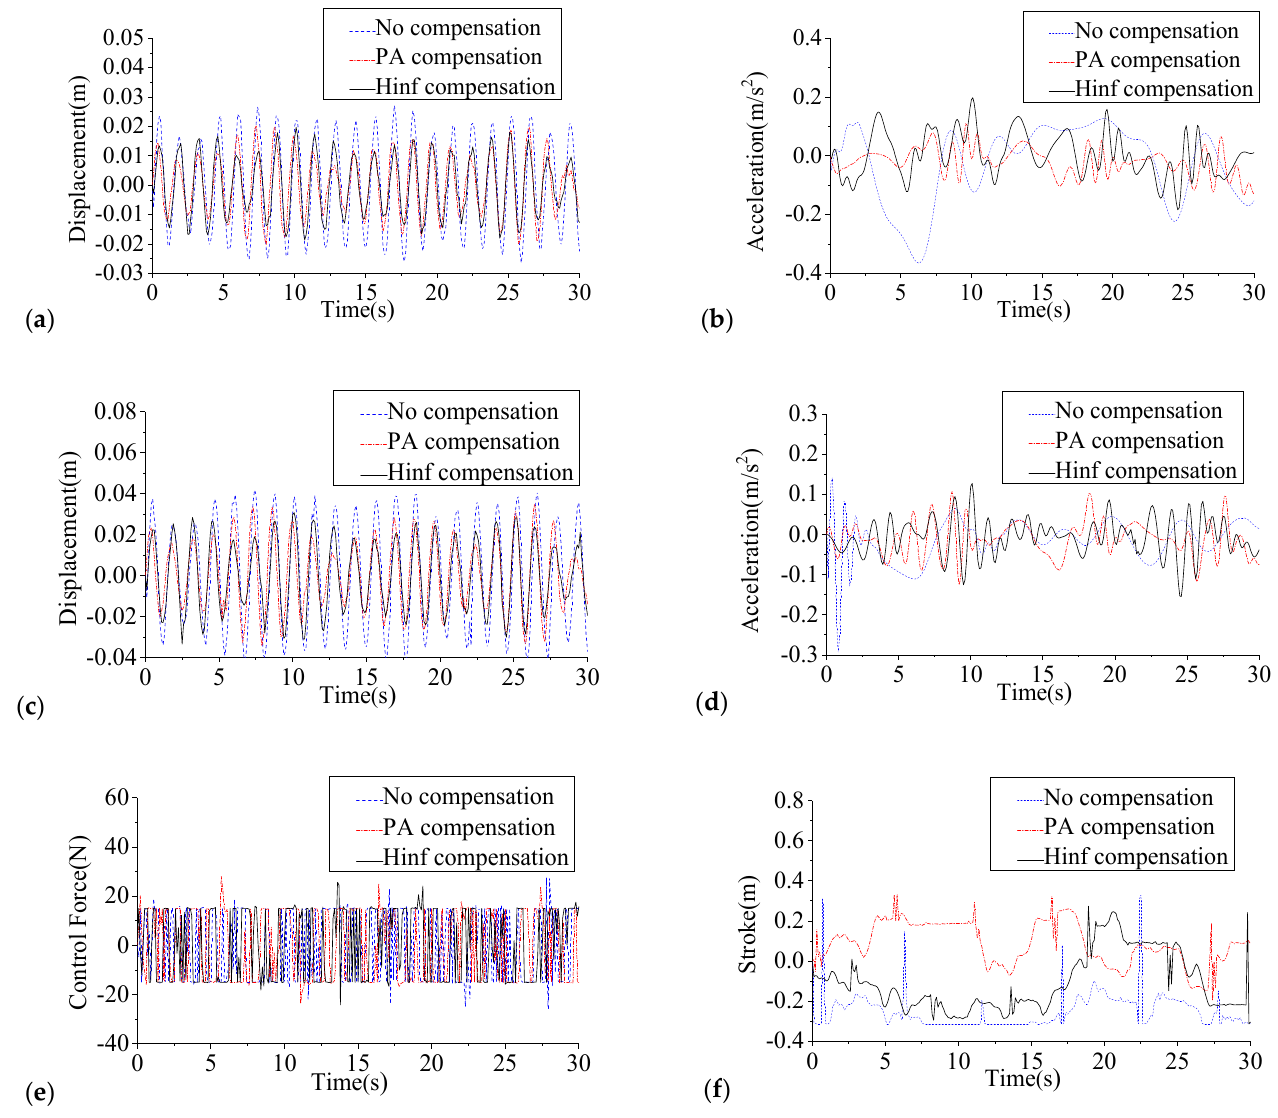
Figure 12. The structural responses and the control parameters of the experiment under the measured results, ( a ) the displacements and ( b ) the accelerations of the 2nd floor, ( c ) the displacements and ( d ) the accelerations of the 4th floor, ( e ) the forces and ( f ) the strokes.